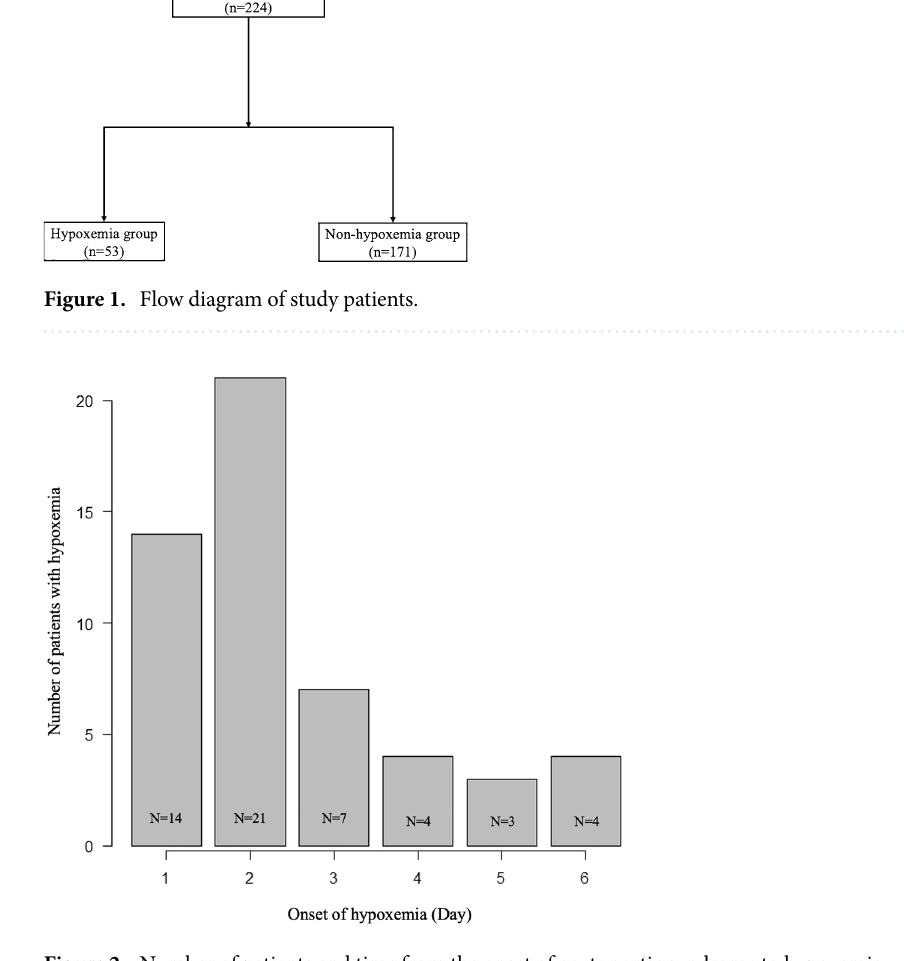
Figure 2. Number of patients and time from the onset of acute aortic syndrome to